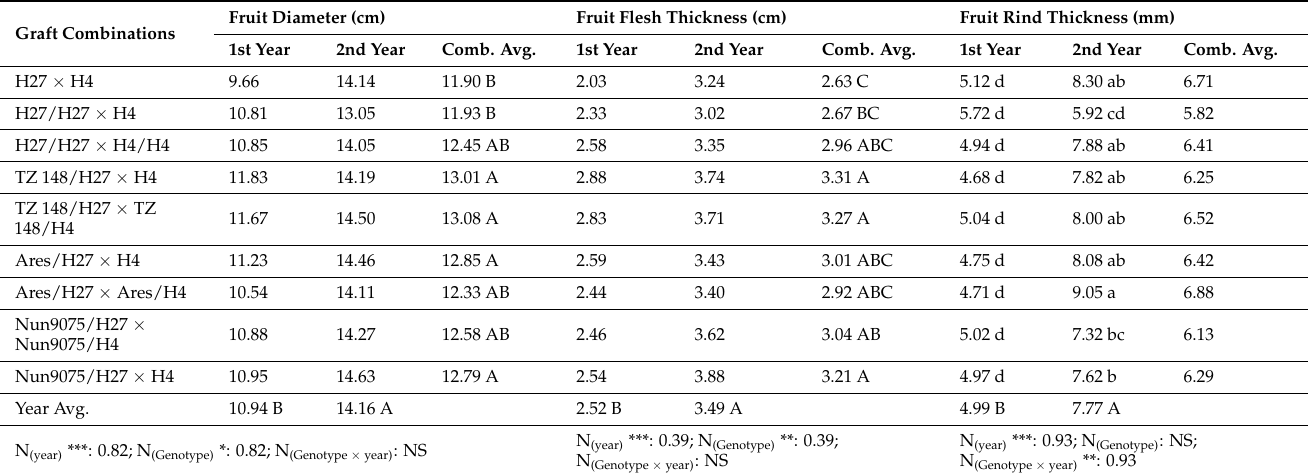
Table 4. Fruit diameter, fruit flesh thickness and fruit rind thickness of different graft combinations in both